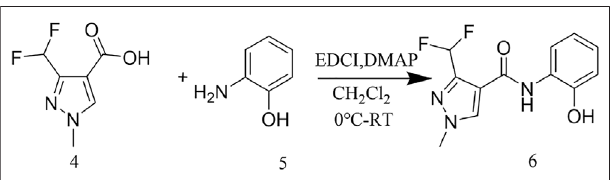
SCHEME 2 | Synthesis of the key intermediate 6